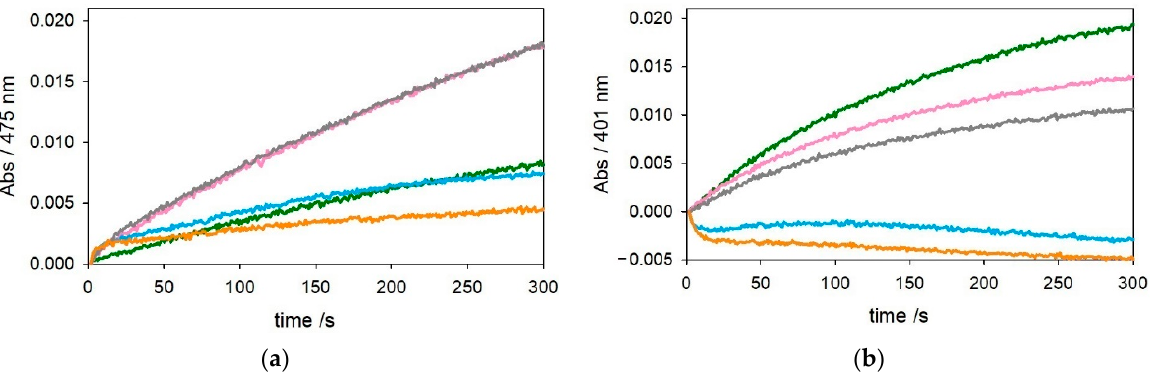
Figure 2. Kinetic profiles of DA (0.3 mM, panel ( a )) and MC (0.3 mM, panel ( b )) oxidation with time in 50 mM HEPES buffer at pH 7.4 and 20 °C in the presence of Cu II alone (25 µM, green trace) and with 1 equiv. A β 1–16 (25 µM, pink), 2 equiv. A β 1–16 (50 µM, grey), 1 equiv. A β 4–16 (25 µM, light blue), and 2 equiv. A β 4–16 (50 µM, orange).